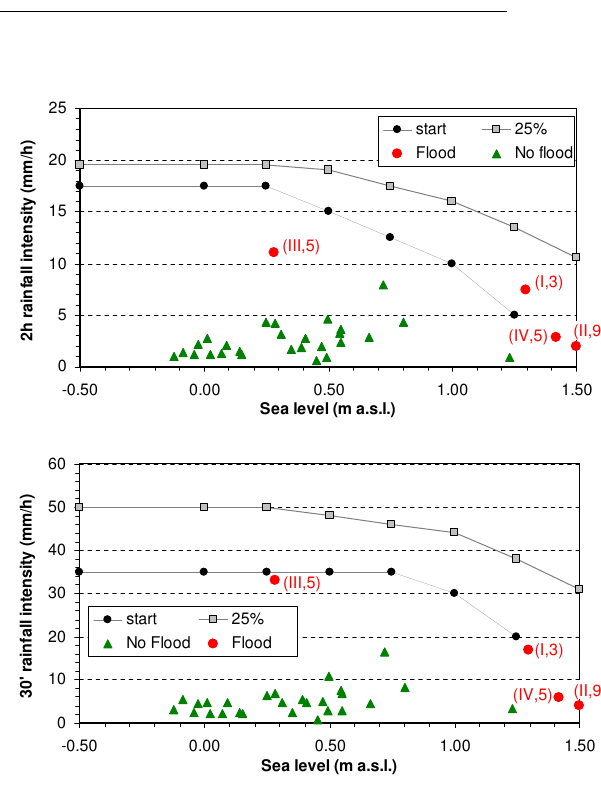
Fig. 11. Rainfall events occurred during year 2009 (classified ac- cording to their average intensity on 2h: top panel and 30min: